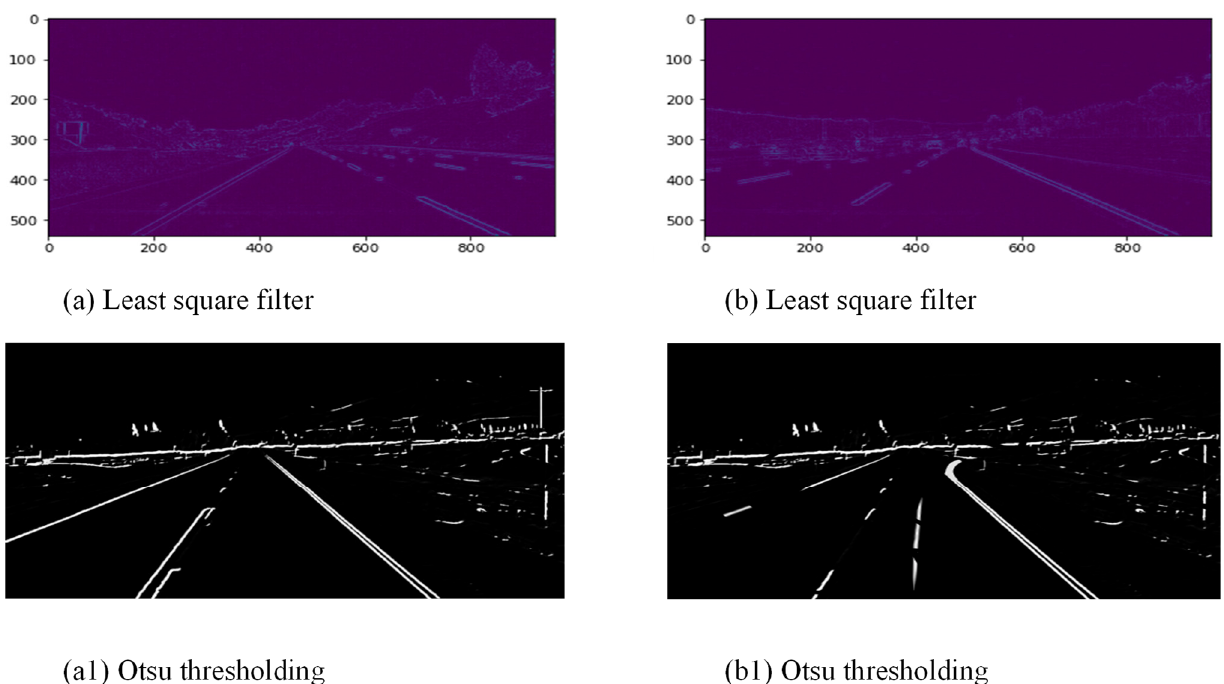
Figure 6. Initial entire pre-processing image least-squares filter ( a , b ) and the result after Otsu thresholding ( a1 , b1 ).